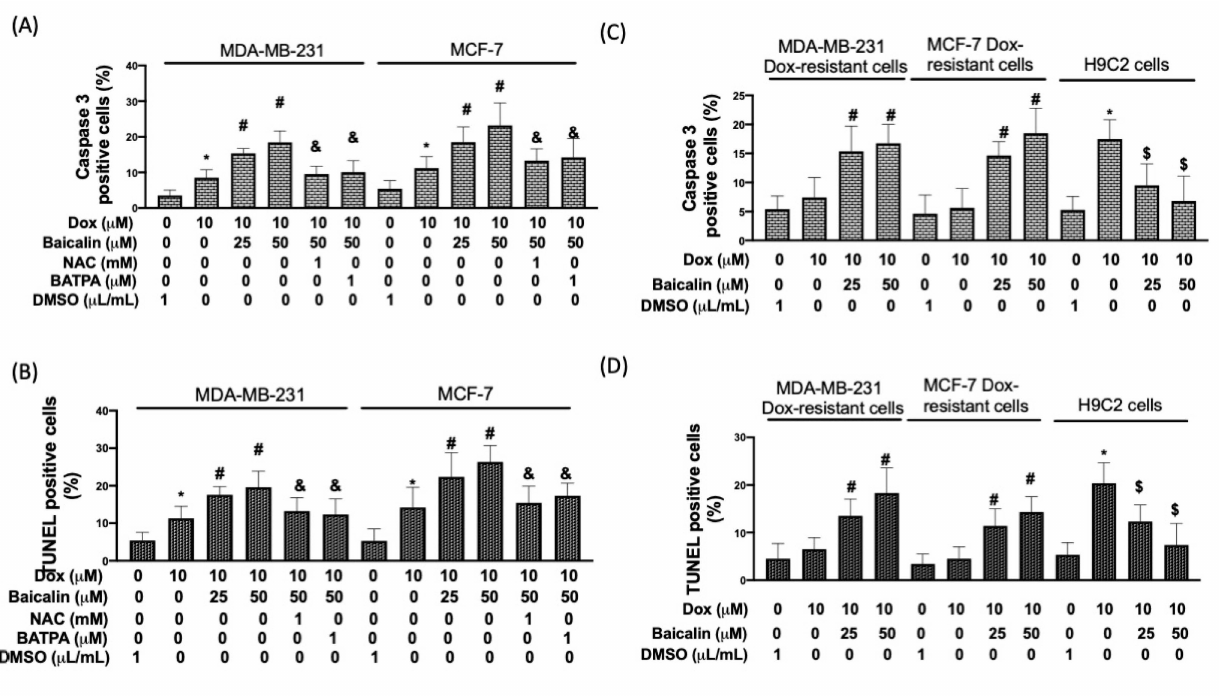
Figure 5. Baicalin increases Dox-induced apoptosis through an ROS/[Ca + ] i mechanism. Cells were treated with 10 µ M Dox or 10 µ M Dox plus 50 or 25 µ M baicalin for 24 h. In some cells, NAC pretreatment inhibited oxidative stress, whereas BAPTA pretreatment reduced the concentration of intracellular calcium. Apoptotic cells were studied as a function of activated-caspase 3 ( A ) and the TUNEL assay (B ) in MDA-MB-231 cells, MCF-7 cells and in ( C , D ) Dox-resistant cells, MCF-7 Dox-resistant cells, and H9C2 cells. Data are expressed as the mean ± SEM of three independent analyses; * p < 0.05 versus untreated control, # p < 0.05 versus Dox treatment, $ p < 0.05 (lower) versus Dox treatment, & p < 0.05 versus Dox+Baicalin (50 µ M)